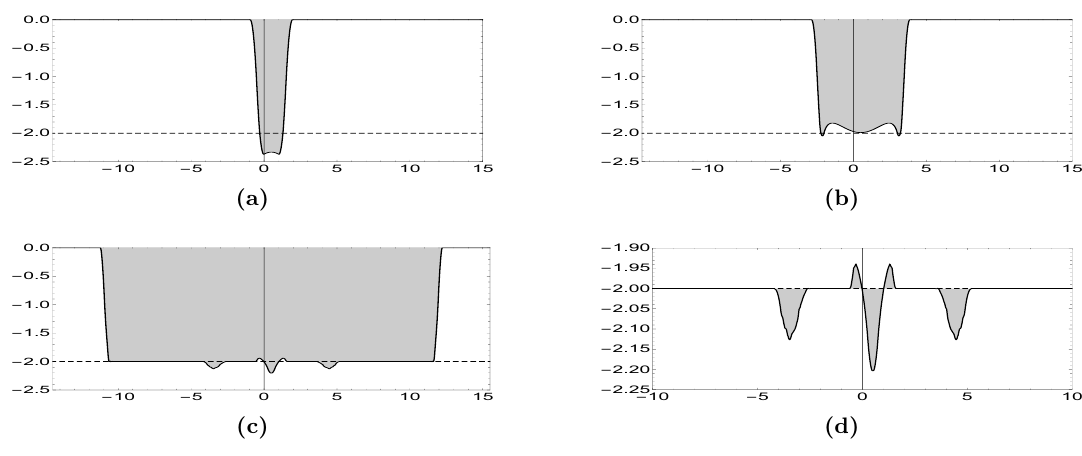
Figure 28. Numerical solutions in the perturbed model for (cid:15) = 20 : 0 at (a) t = 1 : 0030, (b) t = 3 : 0180, (c,d) t = 11 : 6490. Dashed lines correspond to minima at (cid:17) = (cid:0) 2. di(cid:11)erences in behaviour of this solution from the solution of the signum-Gordon model presented in (cid:12)gure 6. We observe that for such high values of the parameter (cid:15) the solutions expand; however, they do not radiate signi(cid:12)cantly. In contradistinction to the solutions with (cid:15) = 0 : 1 we do not see any small waves that escape from the oscillating region and propagate with constant